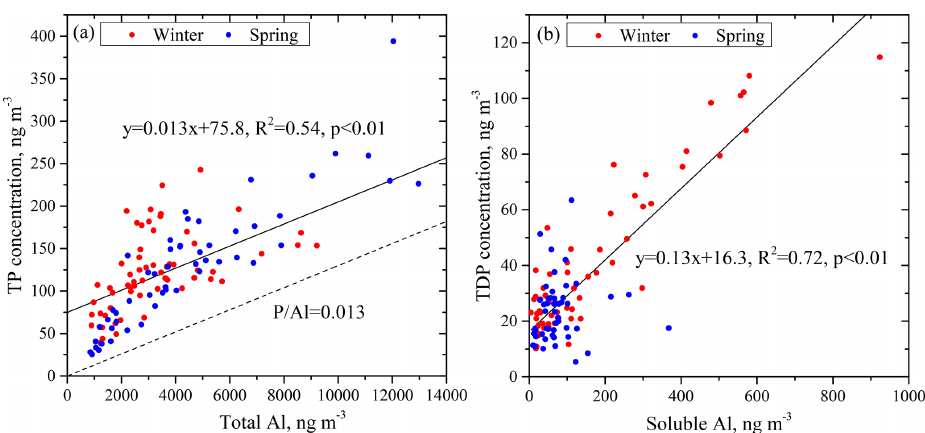
Figure 3. Correlations of TP with total Al (a) and TDP with soluble Al (b) . The line of P / Al = 0.013 represents the ratio of P to Al in the crust.